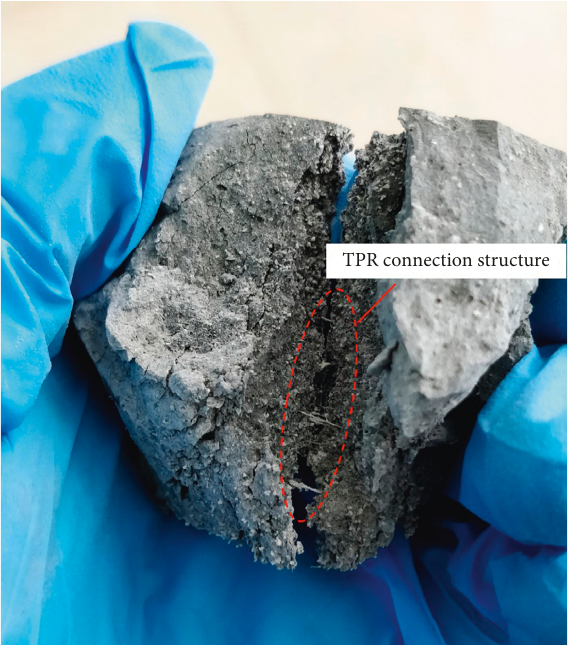
Figure 12: Internal macromorphology of a T3 cement stone